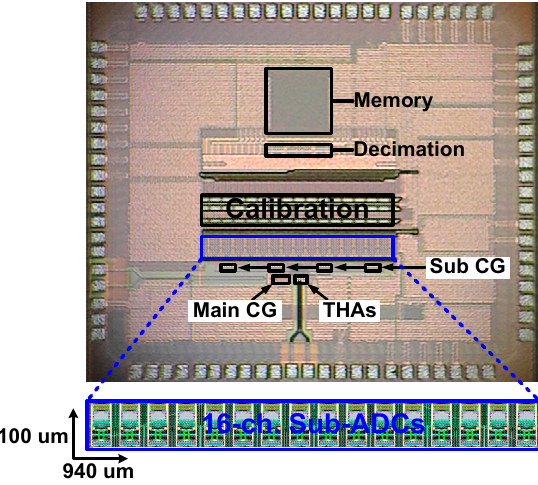
Figure 13. Die photograph. Figure 13. Die